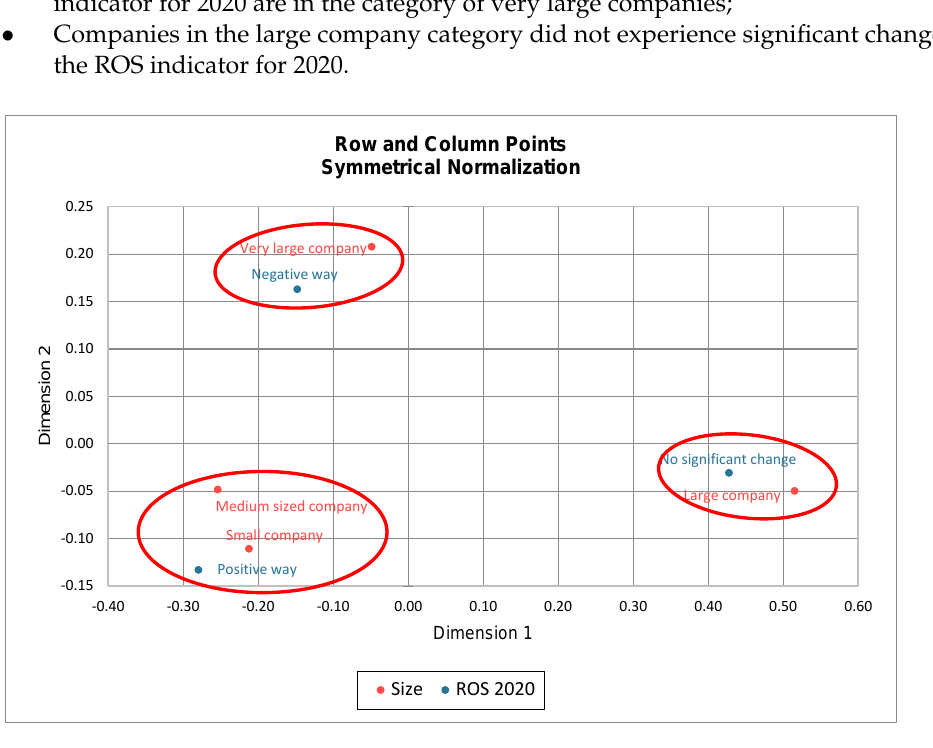
Table 23. Chi-square test (enterprise size vs. change in the ROS 2021 profitability indicator). Source: own research .